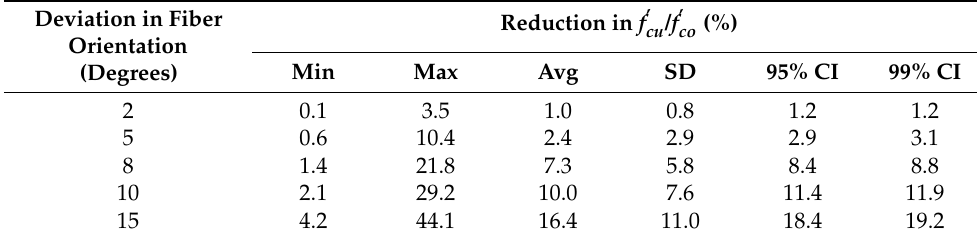
Table 6. Overall reduction in f (cid:48) cu / f (cid:48) co for different deviations in fiber orientation.